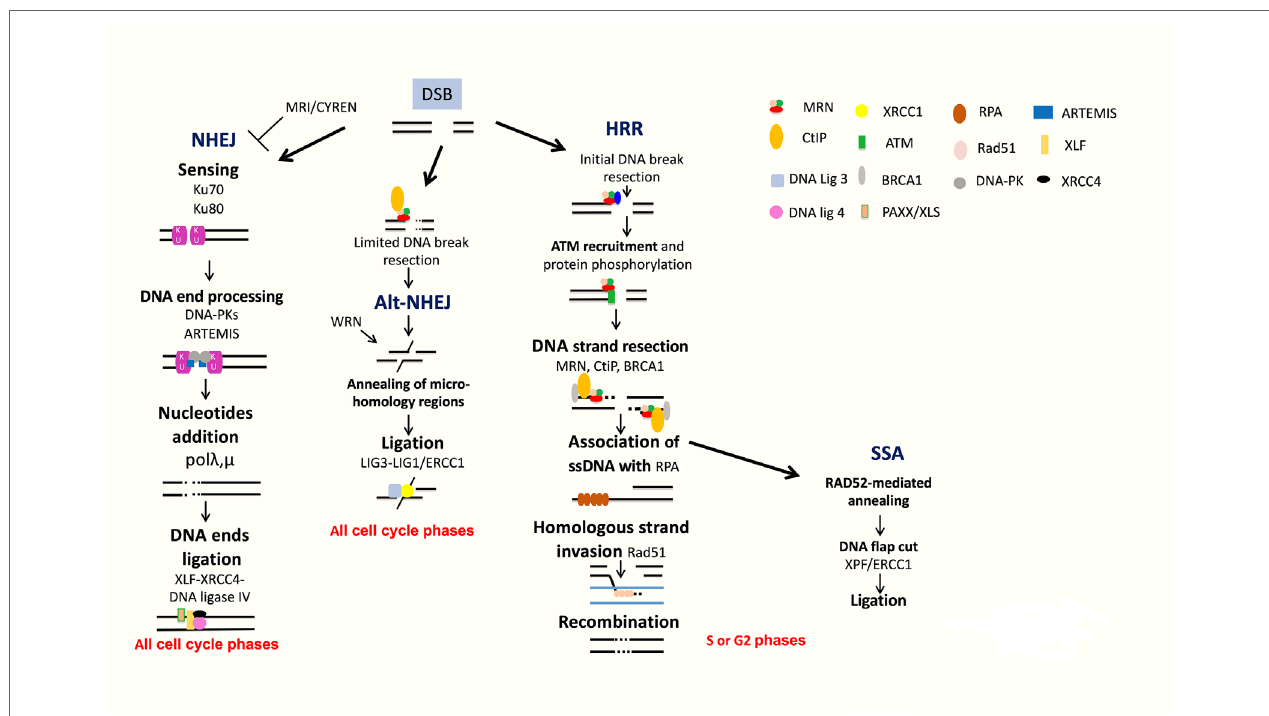
FIGURE 4 | DNA double strand break repair. DSB are repaired by NHEJ or HRR pathways. NHEJ initiates with broken ends bound by Ku, which protects ends, leading to repair with partial resection and ligation of DNA ends. Alt-NHEJ is an alternative less accurate pathway. HRR is an accurate pathway. The DNA ends of the lesion are resected to allow invasion of the single strand into the sister chromatid used as a template for precise resynthesis of damaged DNA part. SSA is used only when two homologous regions flank the DSB site and is